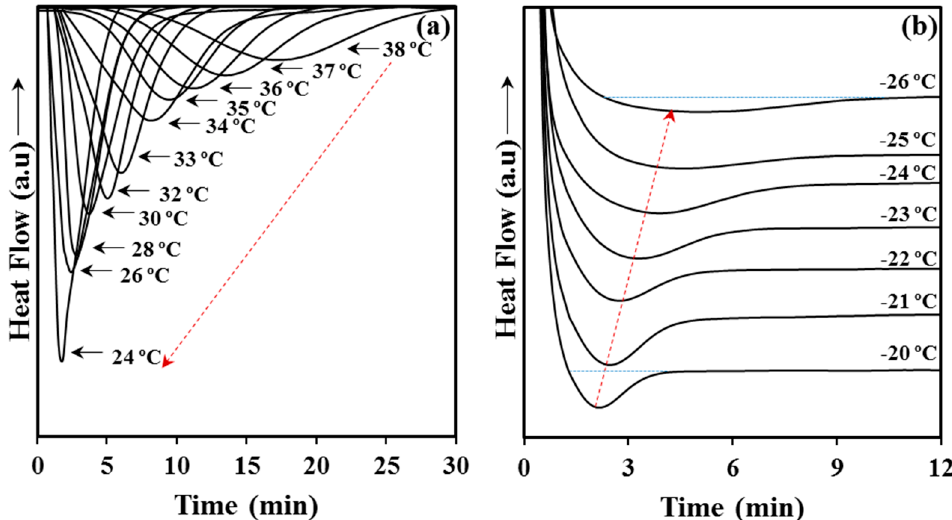
Figure 6. Exothermic DSC peaks corresponding to the isothermal crystallization from the melt state performed between 24 °C and 38 °C ( a ) and the cold crystallization performed between − 26 °C and − 20 °C ( b ).